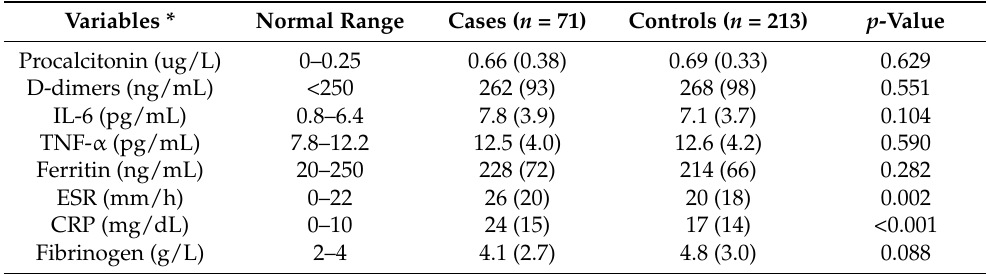
Table 4. Comparison of cytokines and inflammatory markers at hospital admission between cases and